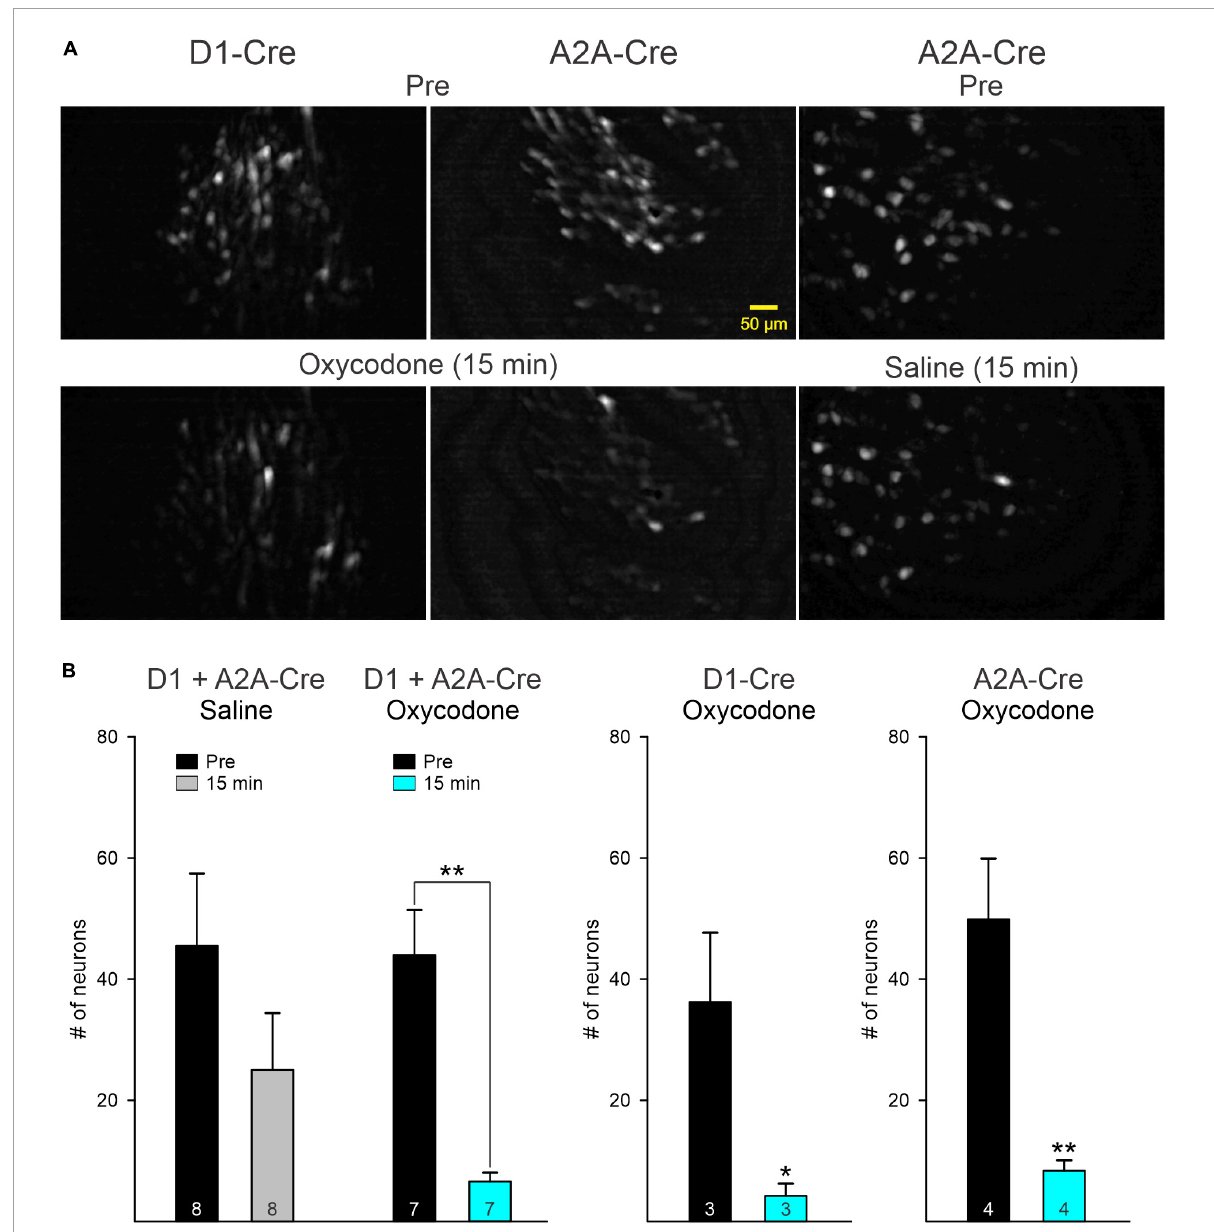
FIGURE2 (A) Maximum intensity projection panels illustrate fluorescent medium-sized spiny neurons (MSNs) visualized with the aid of a Miniscope before (Pre) and 15 min after IP injection of oxycodone or saline. Notice the overall reduction in fluorescence after oxycodone in D1- and A2A-Cre mice. In contrast, fluorescence intensity was only slightly reduced after saline injection. (B) Graphs indicate that the main driver of reduced fluorescence intensity was a significant reduction in the number of MSNs detected by the Miniscope in both D1- and A2A-Cre mice. Saline injection induced a non-significant reduction in the number of neurons, likely reflecting reduced movement as shown in Figure 1C . Graphs on the left show the comparison between saline and oxycodone treatment after grouping together D1 and A2A MSNs (data were analyzed by the two-way ANOVA). Graphs on the right show the effects of oxycodone with D1 and A2A MSNs separated. After oxycodone the reduction in the average number of fluorescent MSNs was statistically significant (for D1 MSNs, p = 0.049 and for A2A MSNs, p = 0.0066, Student’s t -test). * p < 0.05, ** p < 0.01. Numbers inside bars indicate number of recording sessions.